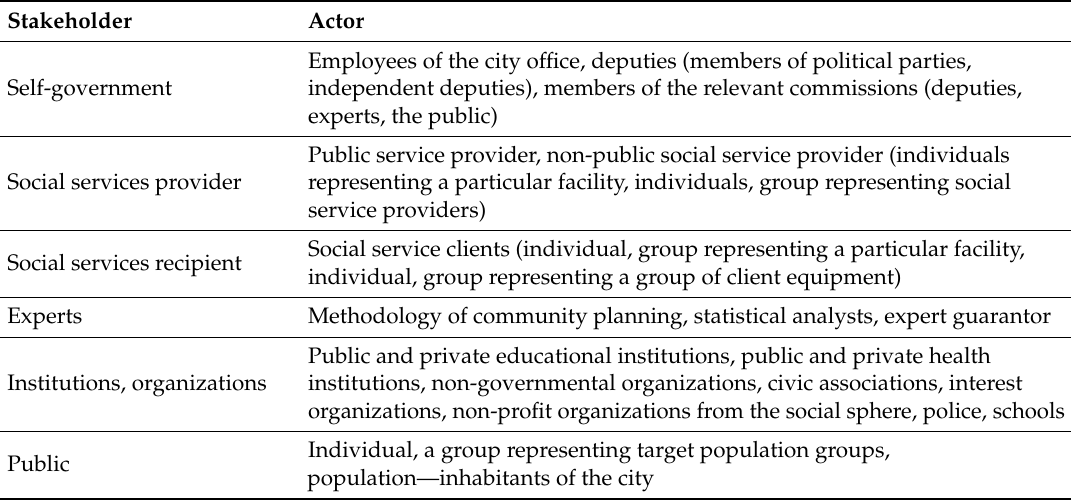
Table 1. Actors involved in community planning policy solving: the case of the Slovak